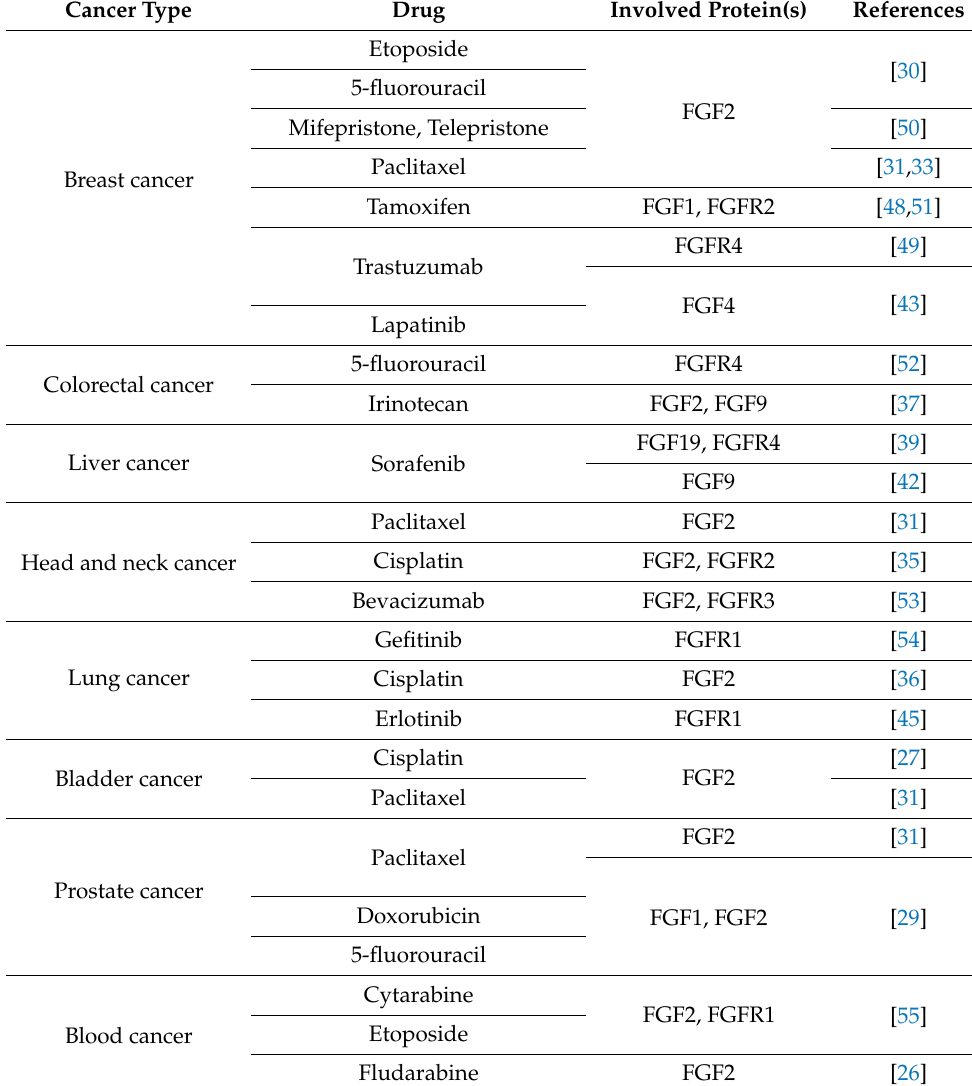
Table 1. Examples of resistant cancer types associated with